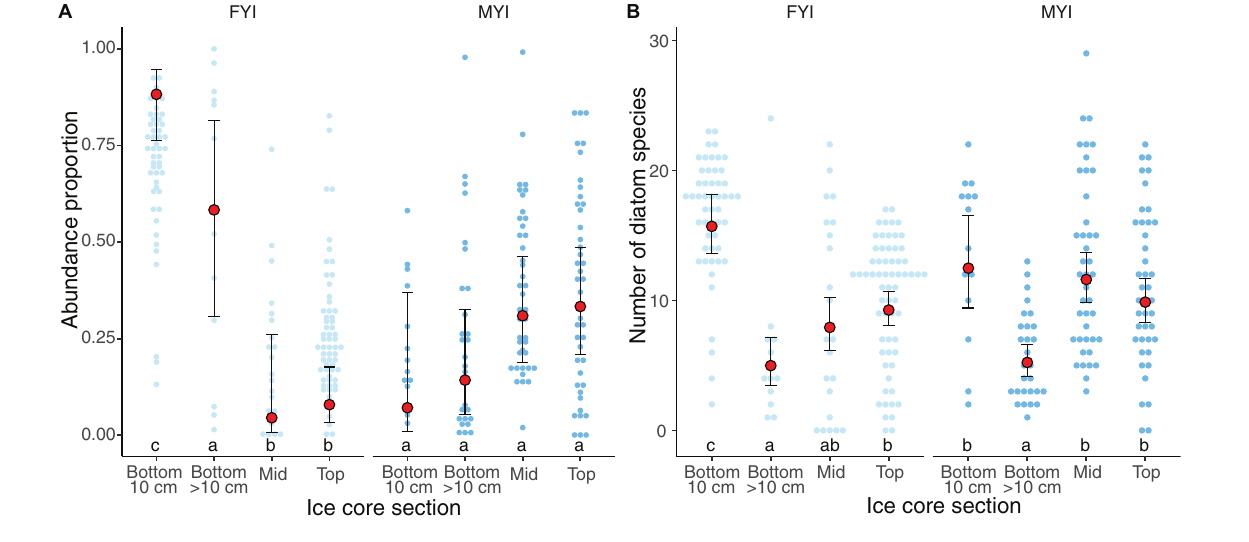
FIGURE 6 | Vertical distribution of ice algae in ice cores, as abundance proportion of all species (A) , and number of diatom species (B) . Small dots indicate percentage of total abundance binned at 1% intervals. Light and dark blue dots represent the age of samples first year ice (FYI) and multiyear ice (MYI), respectively. Red dots indicate the median values and error bars median absolute deviation. Core sections are categorized as bottom 10 cm, bottom sections with cut point > 10 cm, mid sections and top sections of the sea-ice column. Letters on top of x -axis represent multiple Tukey comparisons using the GLMMs, Holm correction and p -value limit of ≤